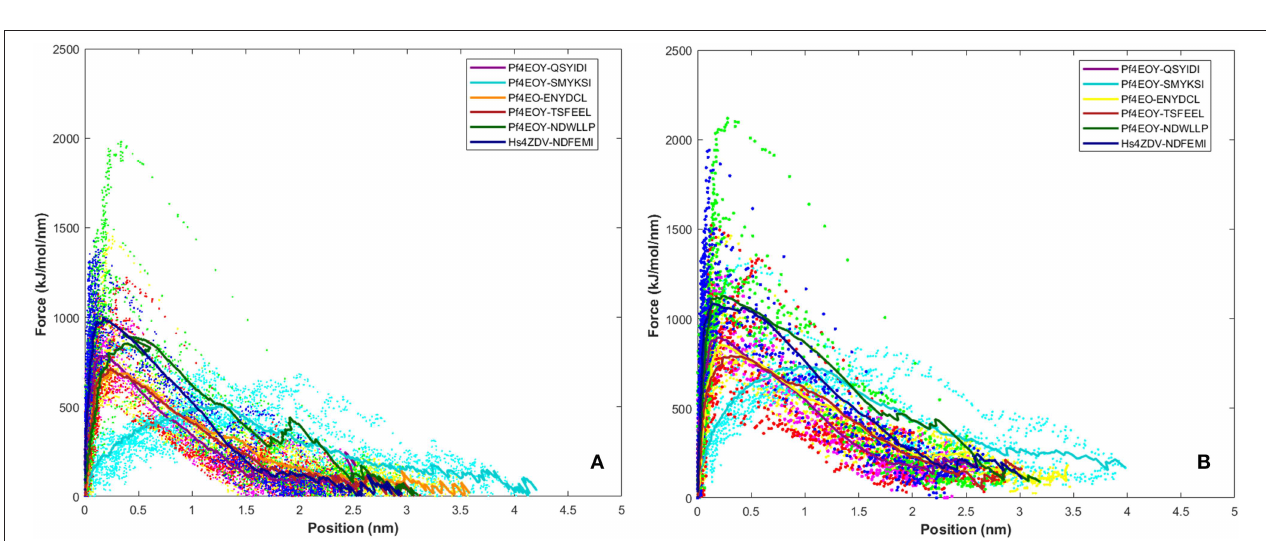
FIGURE 8 | Rupture force profile computed for the AIM/LIR - Pf Atg8/ Hs LC3 complexes at pull velocities (A) 0.010 nm/ns and (B) 0.025 nm/ns for the LIR motifs (i) Pf Sec62 QSYIDI (magenta), (ii) Pf Sec62 SMYKSI (cyan), (iii) Pf Sec62 ENYDCL (yellow), (iv) Pf Sec62 TSFEEL (red) and (v) Pf Atg3 NDWLLP (orange) LIR motifs bound to Pf Atg8 and (vi) Hs Sec62 NDFEMI (blue) bound to HsLC3. The dotted lines represent the individual dissociation profile of 10 SMD trajectories for each peptide-protein complex and the solid line represents their